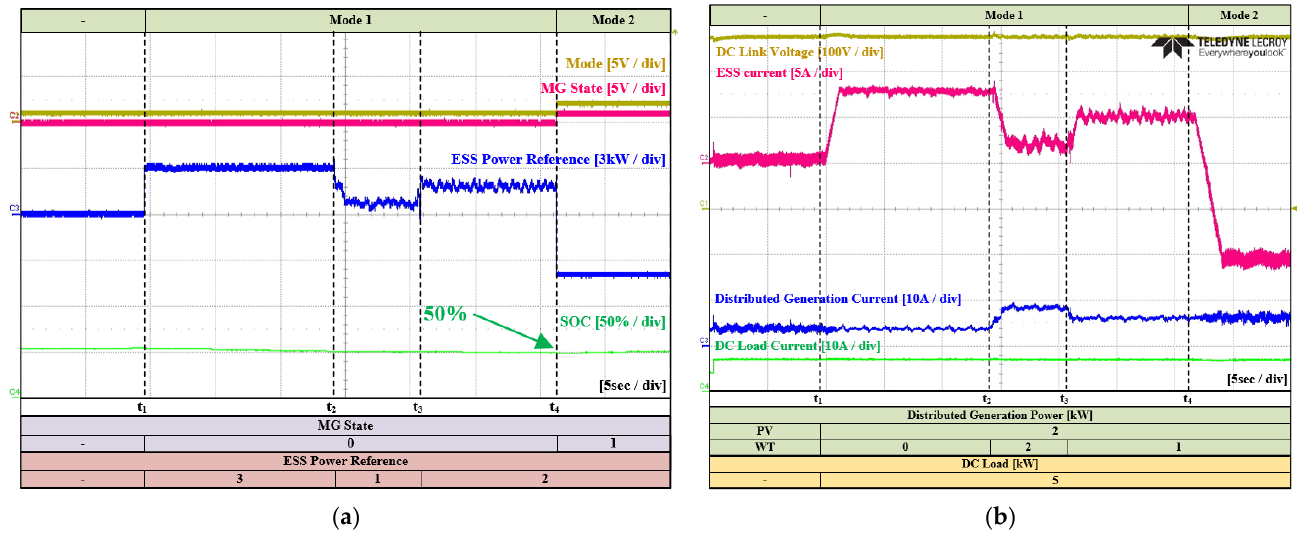
Figure 21. Experimental waveforms of microgrid operation Modes 1 and 2 in grid-connected op- eration (2): ( a ) waveforms of the input data ( MG STATE , SOC) and output data (Mode, ESS power reference) of ANN; ( b ) waveforms of the current of DG, DC load, and DC link voltage.